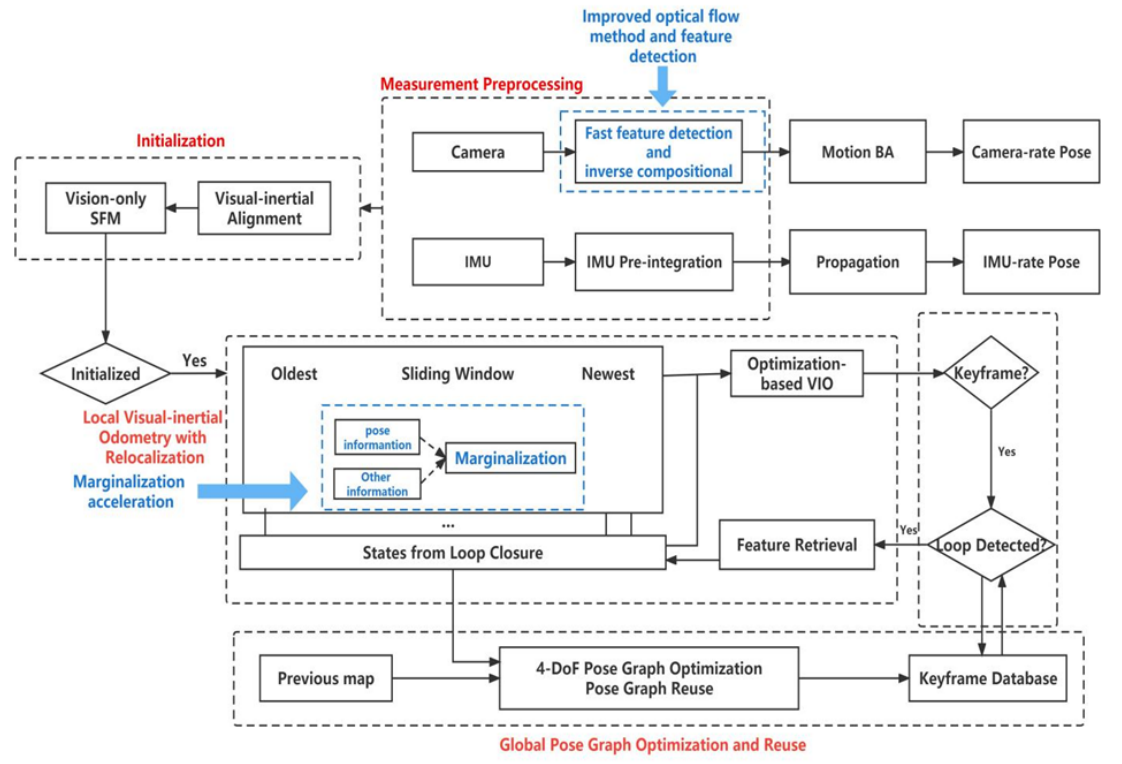
Figure 1. VINS-MONO process structure diagram. The blue dotted box and blue font are the im- provements of VINS-MONO algorithm in this paper. improvements of VINS-MONO algorithm in this